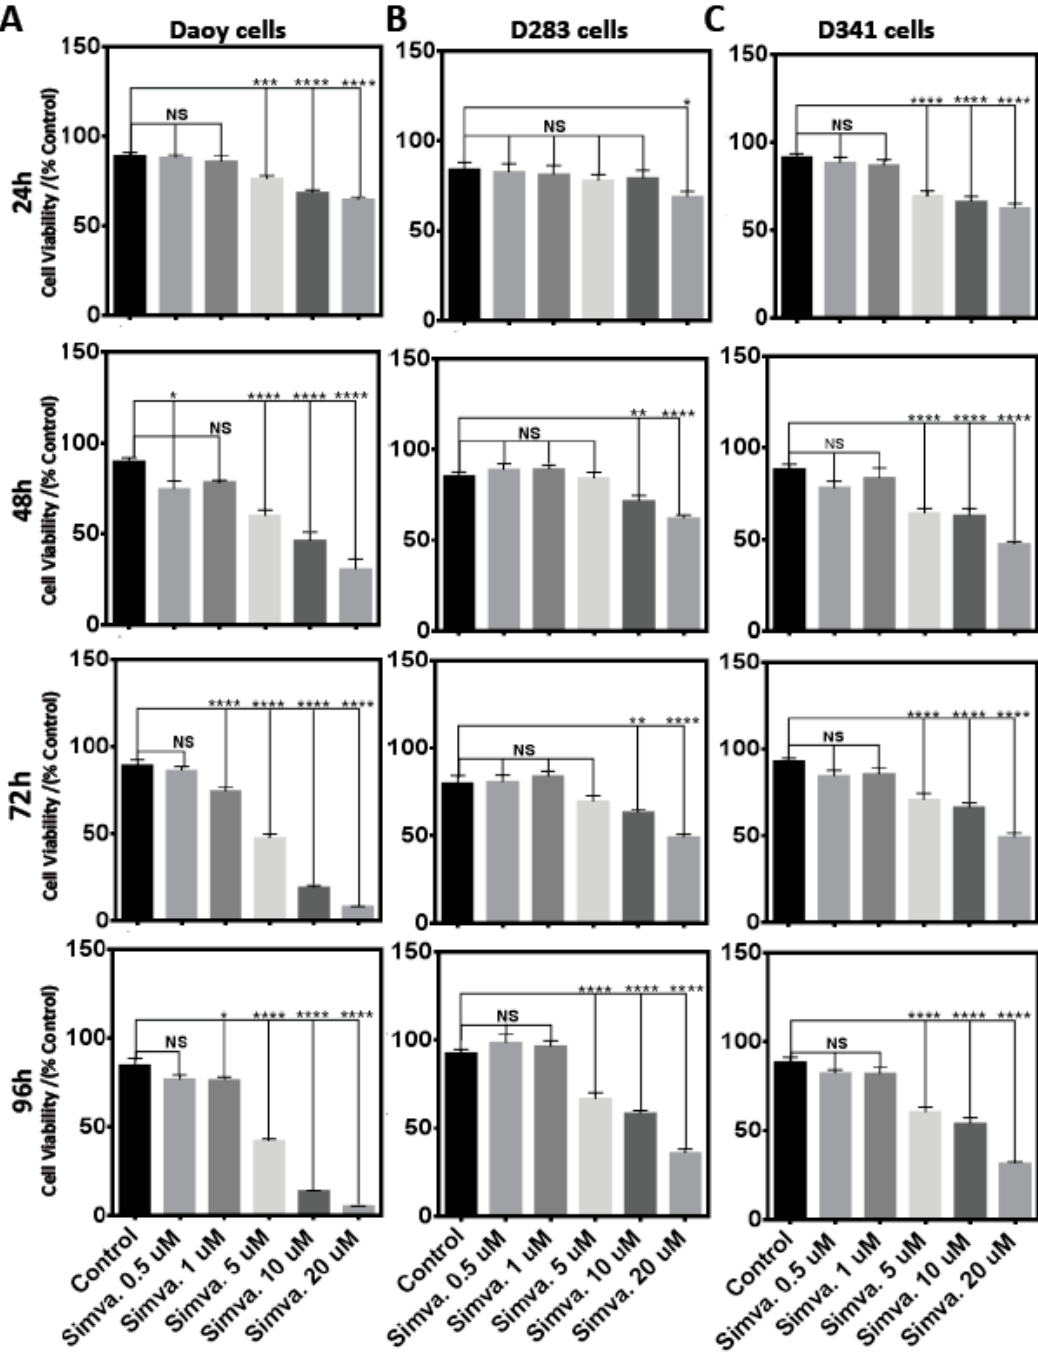
Figure 1. Simvastatin treatment induces significant cell death in medulloblastoma cells. Cell viability assays of Daoy ( A ), D283 ( B ), and D341 ( C ) cells, using dose-dependent analysis by 3-(4,5-Dimethylthiazol-2-yl)-2,5-diphenyltetrazolium bromide (MTT), performed every 24 h until 96 h (24 h, 48 h, 72 h, and 96 h). Medulloblastoma cells were treated with 0.5–20 µ M simvastatin. Statistical significance is reported by one-way ANOVA using GraphPad Prism 7.0. The p -value is reported as **** p < 0.0001, *** p < 0.001, ** p < 0.01, or * p < 0.05. Data are expressed as means ± SEM, and n = 15–20.